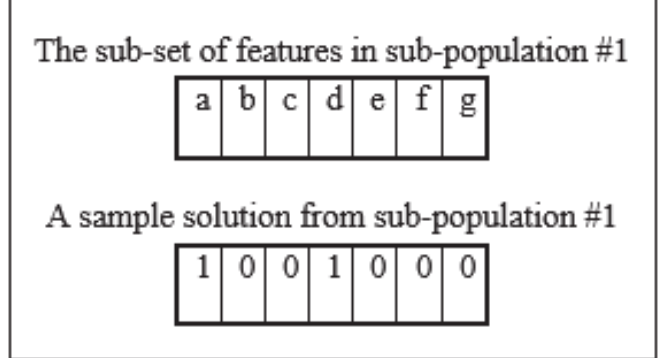
Figure 4. A sample PartialSolution from sub ‐ population #1.